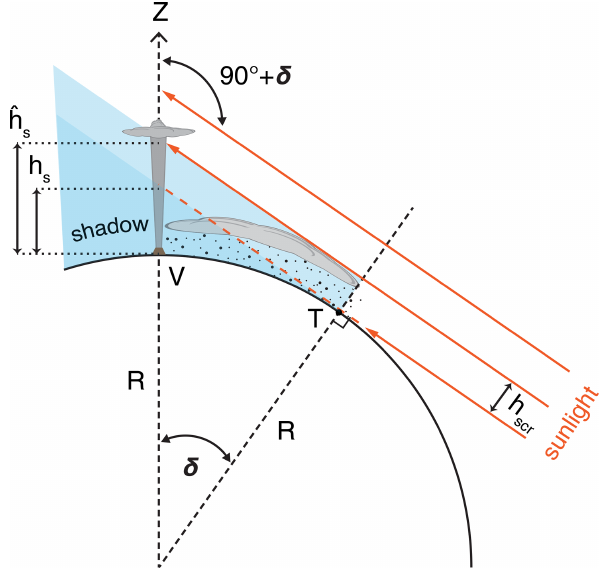
Figure 6. The geometry of an eruption column protruding through the earth’s shadow at twilight. At a solar depression of δ , a graz- ing ray tangent to the surface at point T casts a geometric shadow of height h s at the volcano’s location V . Grazing rays below the screening height h scr are strongly attenuated by air molecules, haze, and meteorological or volcanic clouds, raising the base of the scat- tering layer and thus increasing the effective shadow height ˆ h s . Here the spherical earth’s radius is R and the apparent decrease in δ due to atmospheric refraction is